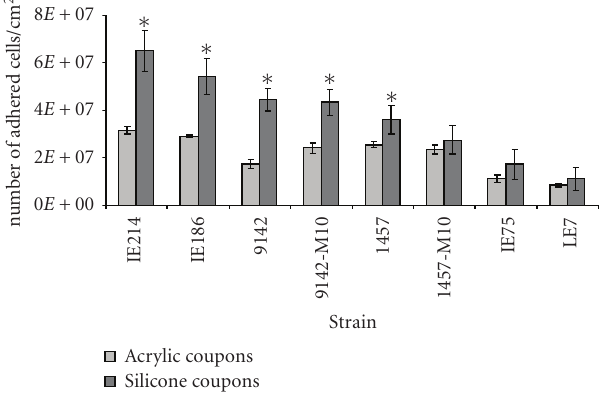
Figure 1: Number of adhered cells per cm 2 onto acrylic ( ) and silicone ( ) coupons, after a 2-hour period of contact for S. epidermidis strains IE214, IE186, 9142, 9142-M10, 1457,